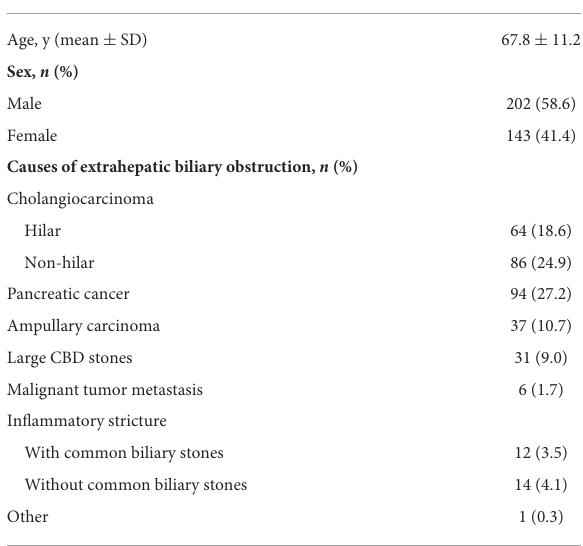
TABLE 1 Clinical characteristics of eligible